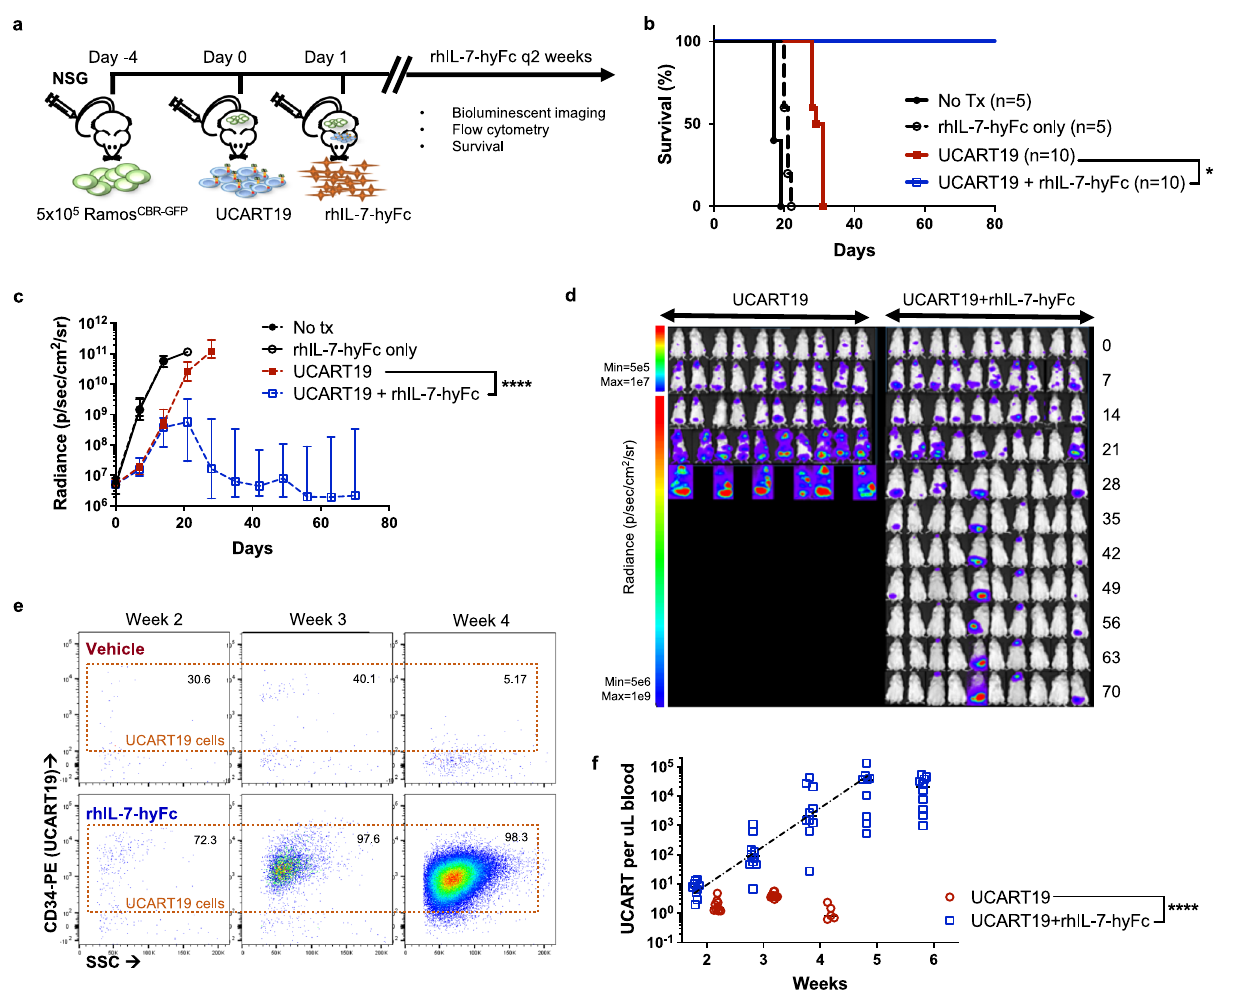
Fig. 2 rhIL-7-hyFc dramatically enhances UCART19 expansion, persistence, and anti-tumor ef fi cacy in NSG mice engrafted with CD19 + Ramos CBR-GFP cells in vivo. a Experimental schema: NSG mice were injected via tail vein with 5 × 10 5 Ramos B lymphoma cells expressing click beetle red luciferase (CBR) and green fl uorescent protein (GFP) (Ramos CBR-GFP ) on day − 4, followed by 1 × 10 6 UCART19 on day 0, and rhIL-7-hyFc 10 mg/kg subcutaneously every 2 weeks for a total of three doses starting day + 1 ( n = 5 for no tx and rhIL-7-hyFc only groups; n = 10 for UCART19 and UCART19 + rhIL-7-hyFc groups). b Survival analysis for each treatment group. p Values were calculated using two-sided Wilcoxon test (UCART19 + rhIL-7-hyFc vs. UCART19 alone, p = 0.018). c Tumor burden measured by bioluminescent imaging (BLI). Data represent median ± 95% CI. Two-tailed p values were calculated using linear mixed model for repeated measurement data followed by post hoc multiple comparisons for between-group differences (UCART19 + rhIL-7-hyFc vs. UCART19 alone, p < 0.0001). d BLI images of individual mice treated with UCART19 only (left) and UCART19 + rhIL-7-hyFc (right). e , f Quantitative fl ow cytometric analyses of UCART19 expansion in peripheral blood. Representative FACS plots ( e ) and absolute UCART19/ μ l counts from peripheral blood ( f ). Each data point represents one mouse. Two-tailed p-values were calculated using a linear mixed model for repeated measurement data followed by post hoc multiple comparisons for between-group differences (UCART19 + rhIL-7-hyFc vs. UCART19 alone, p < 0.0001). Source data are provided as a